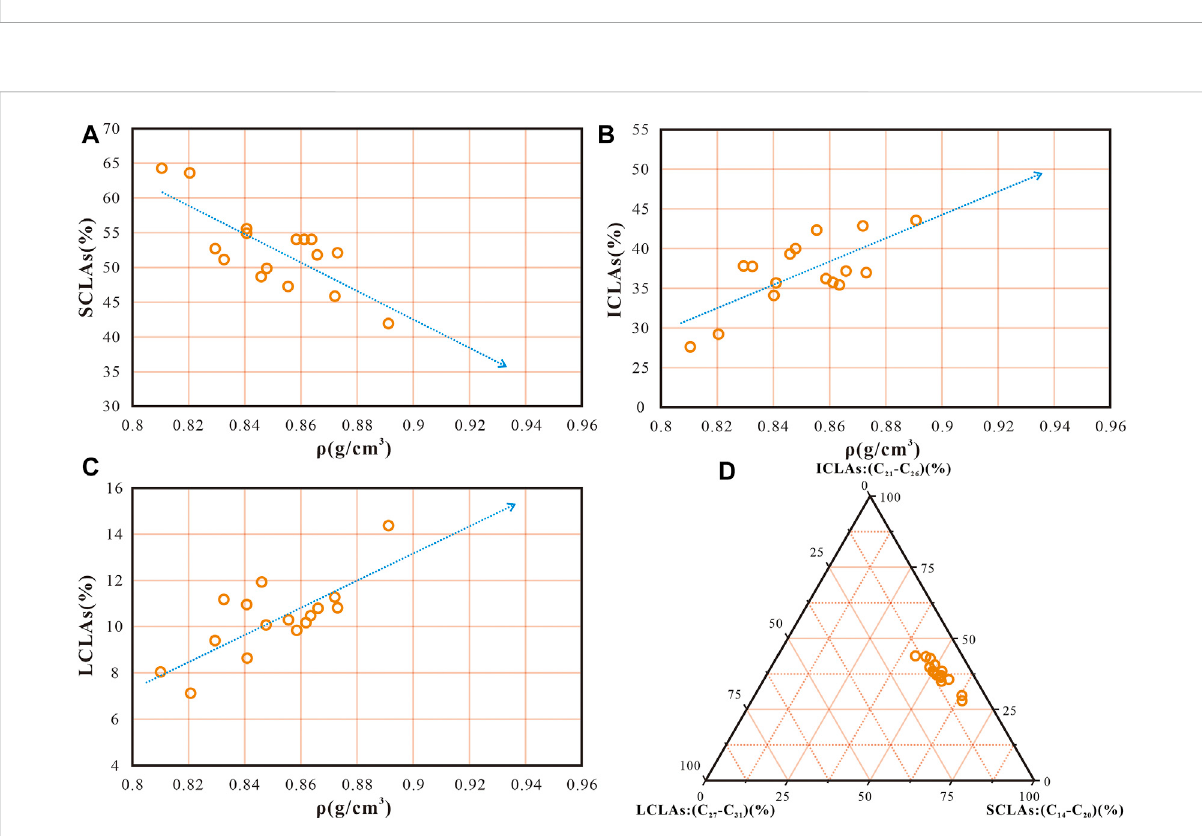
FIGURE 9 Plotofdistribution characteristics ofn-alkanes fromthestudiedCarboniferouscrude oilintheHongchefaultzone. (A) Plotofdensity( ρ )versus short chain length n-alkanes (SCLAs); (B) Plot of density ( ρ ) versus medium-chain n-alkanes (ICLAs); (C) Plot of density ( ρ ) versus long-chain n-alkanes (LCLAs); (D) Ternary plot of SCLAs, ICLAs, and